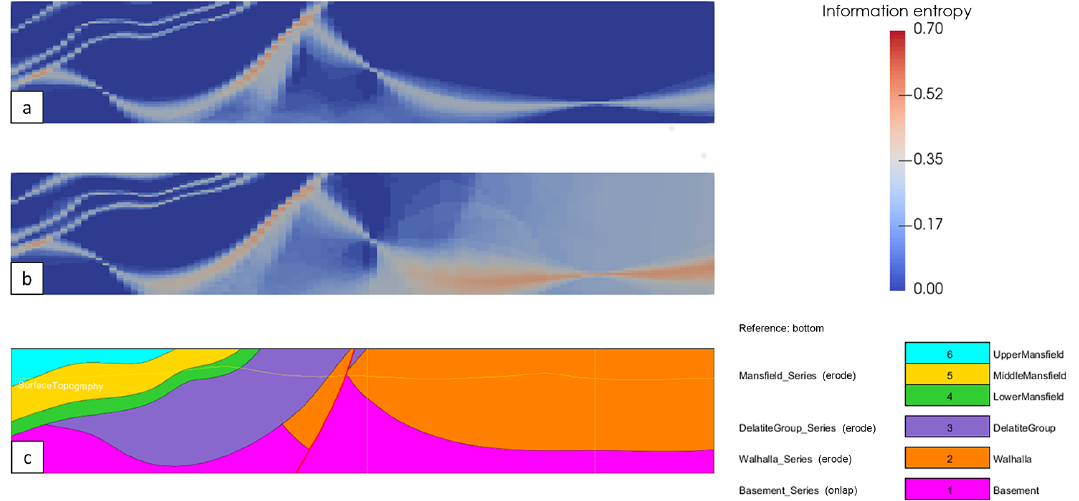
Figure 11. Effect of pole (a) versus dip (b) perturbation on a cross section of the Mansfield model (c) ; orientations are perturbed over a von Mises–Fisher distribution with κ =